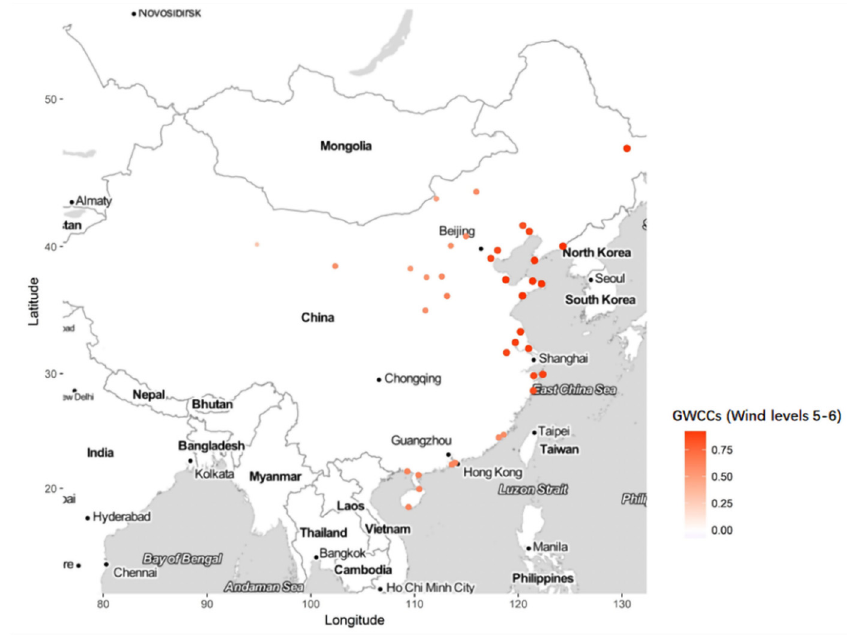
Figure 6. Geographically-weighted correlation coefficients (GWCCs) between UA triggering frequency and wind levels 5–6.